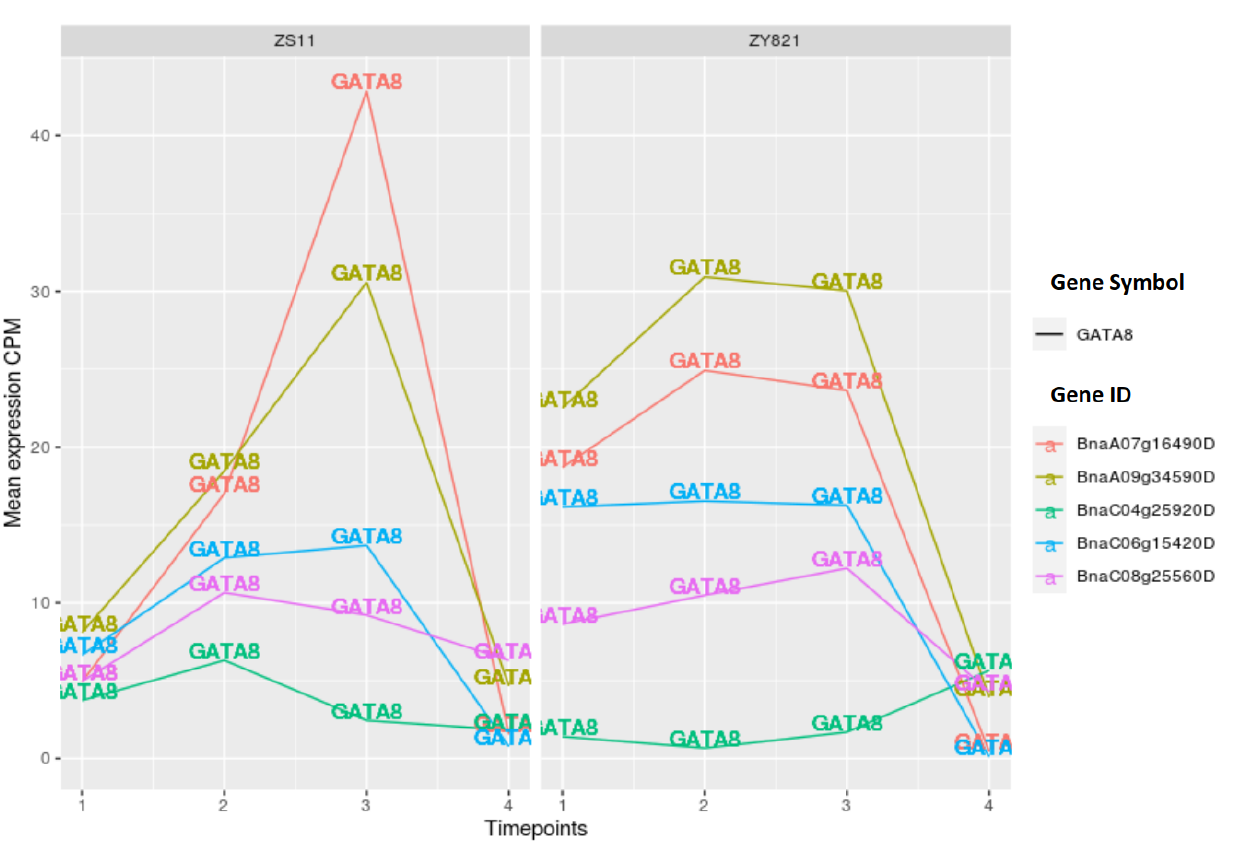
Figure 5. Expression values of GATA8 orthologous genes. Time points 1 to 4 represents day 7, day 10, day 15, and day 45 after